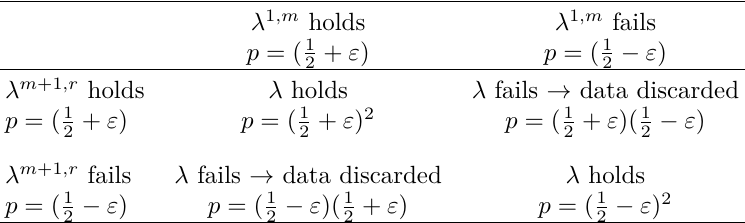
Table 23: The Four Possible Cases of λ 1 ,m and λ m +1